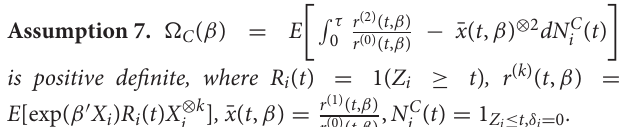
Frontiers in Genetics |